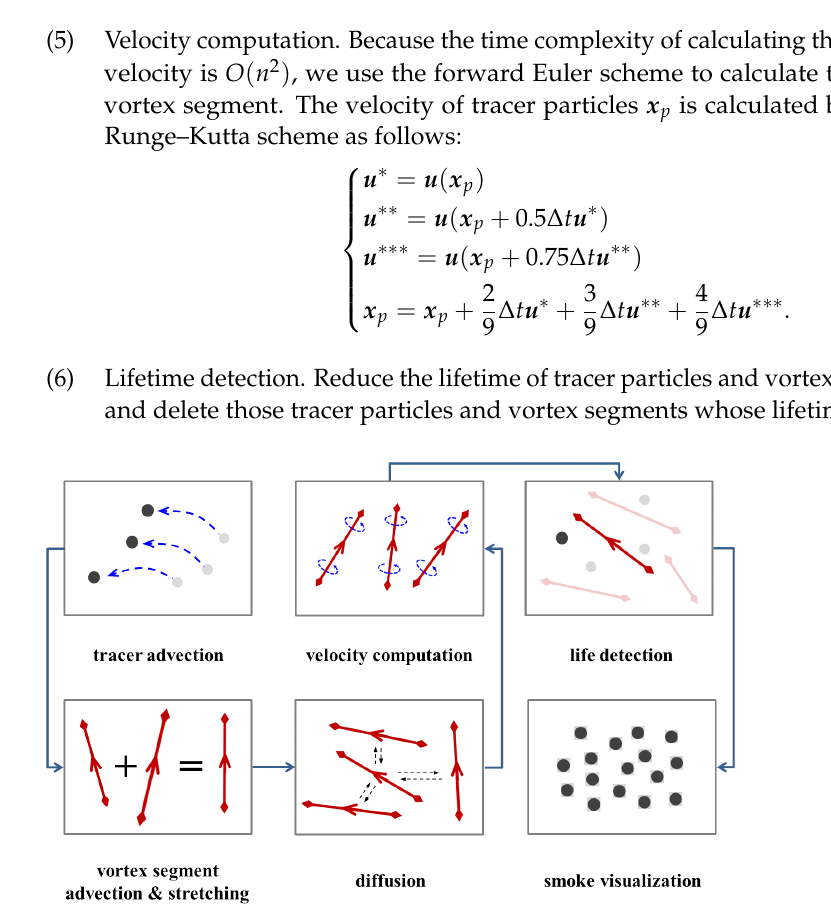
Figure 4. Overview of our smoke simulation framework.